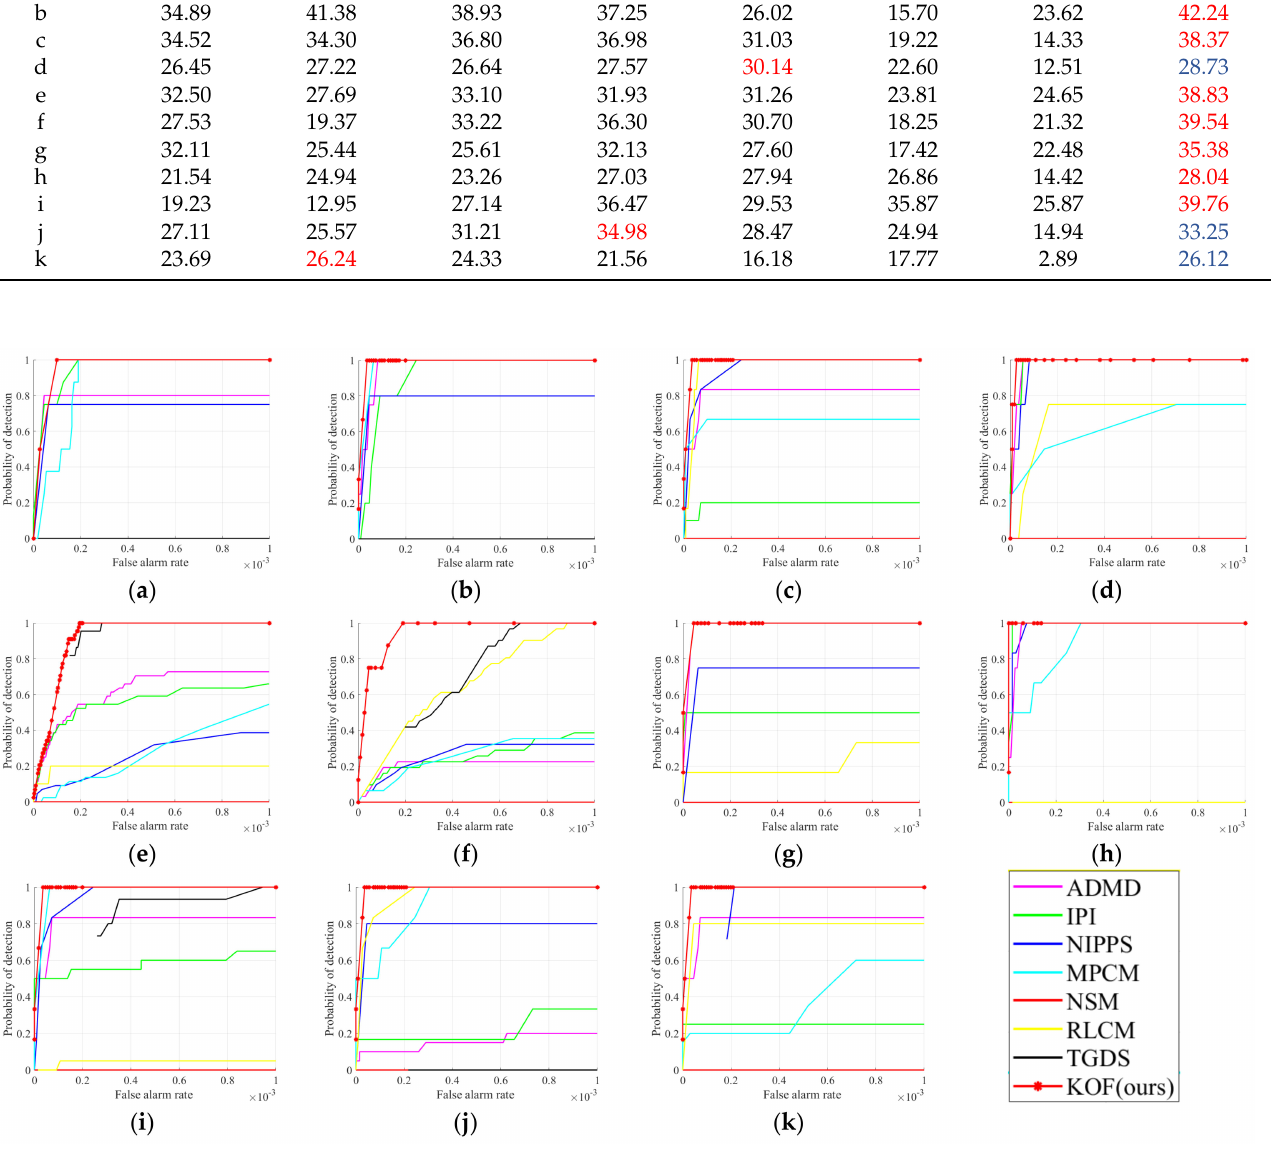
Figure 10. The ROC curves obtained by different methods. ( a – k ) corresponding to Figure 9a–k,